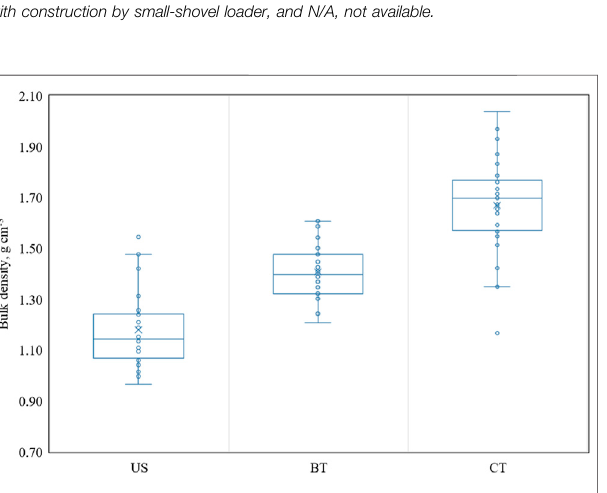
FIGURE 5 | Box and whisker plots of bulk density among the disturbed types; undisturbed and shallow disturbance (US), bladed skid trail (BT), and compacted road surface (CT). The circles are data and the line and X are mean value.